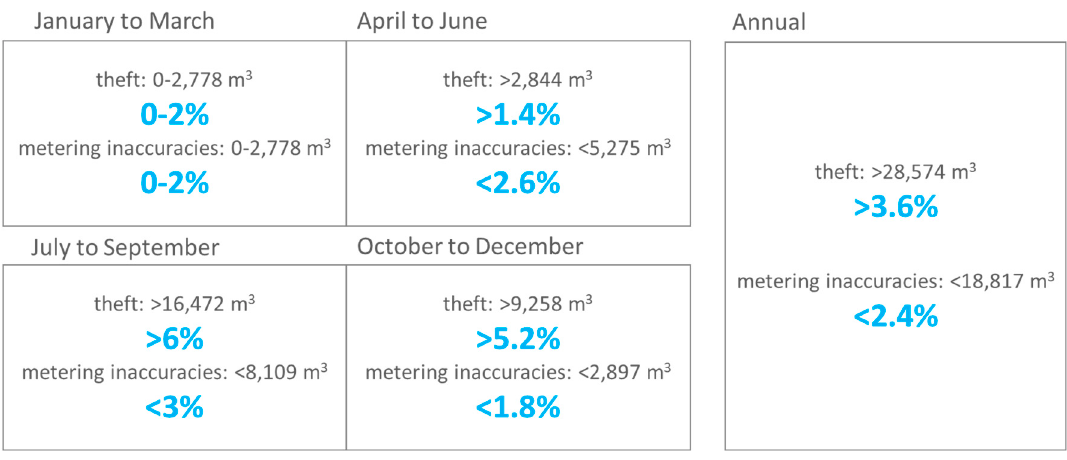
Figure 17. Split of apparent losses (mean values) with the assumption that metering inaccuracies are proportional to BAC, where the limits are true if theft during January to March is negligible.